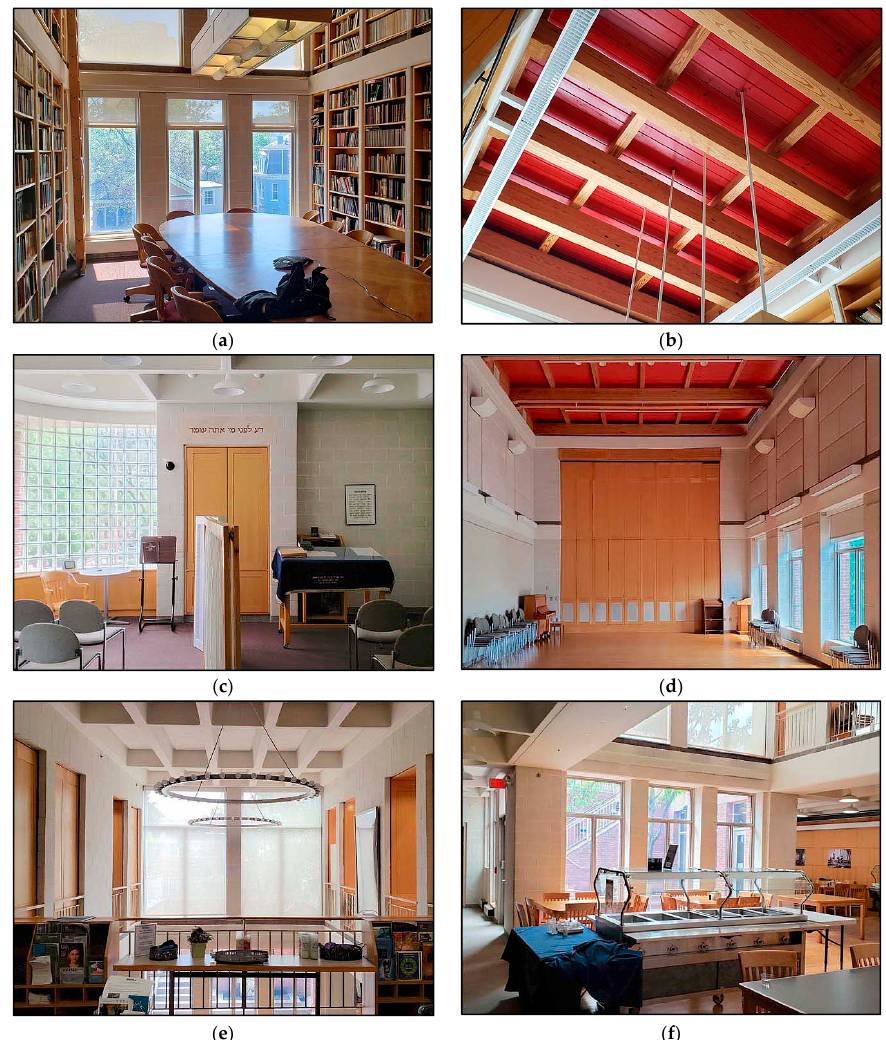
Figure 5. Slifka Center for Jewish Life at Yale, Interior Views. ( a ) Library (upper level); ( b ) library ceiling (upper level); ( c ) Beit Midrash (middle level); ( d ) chapel/multipurpose (middle level); ( e ) view from entrance (ground level); ( f ) dining commons (lower level). Image Credit: © 2019 Jeremy Kargon.